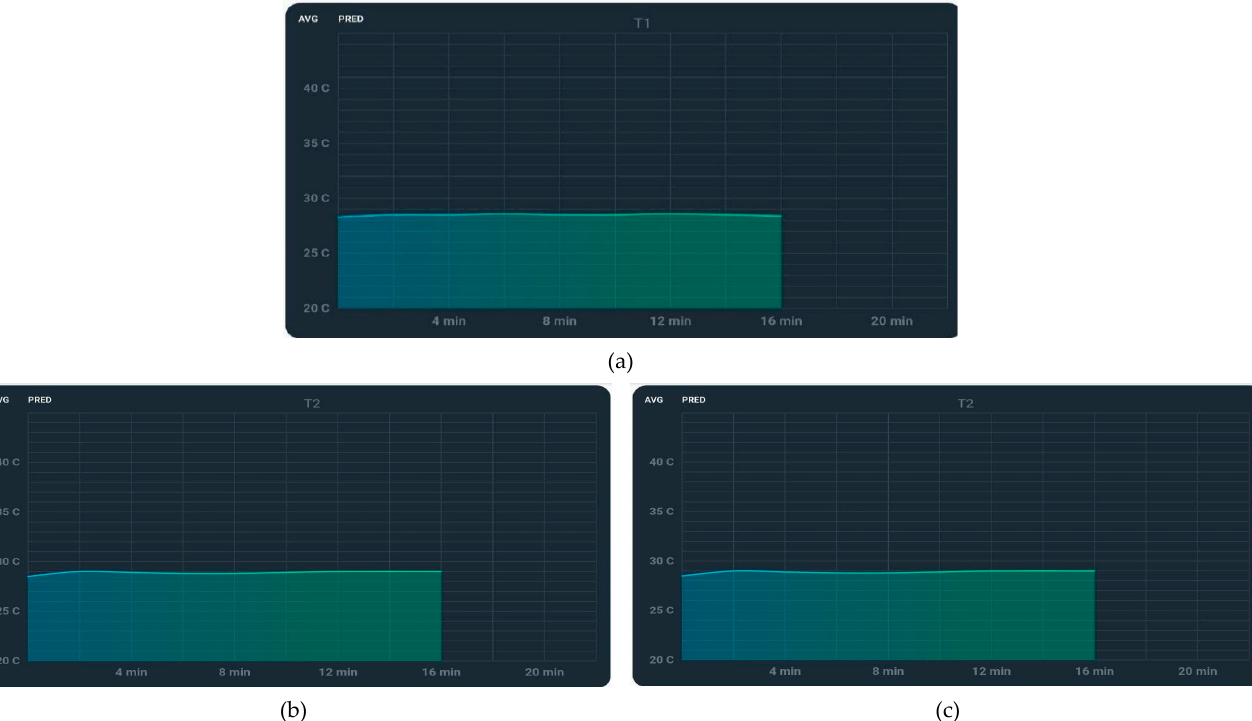
Figure 17. Temperature measurements: ( a ) from location A1, ( b ) from location A2, and ( c ) from location A3.